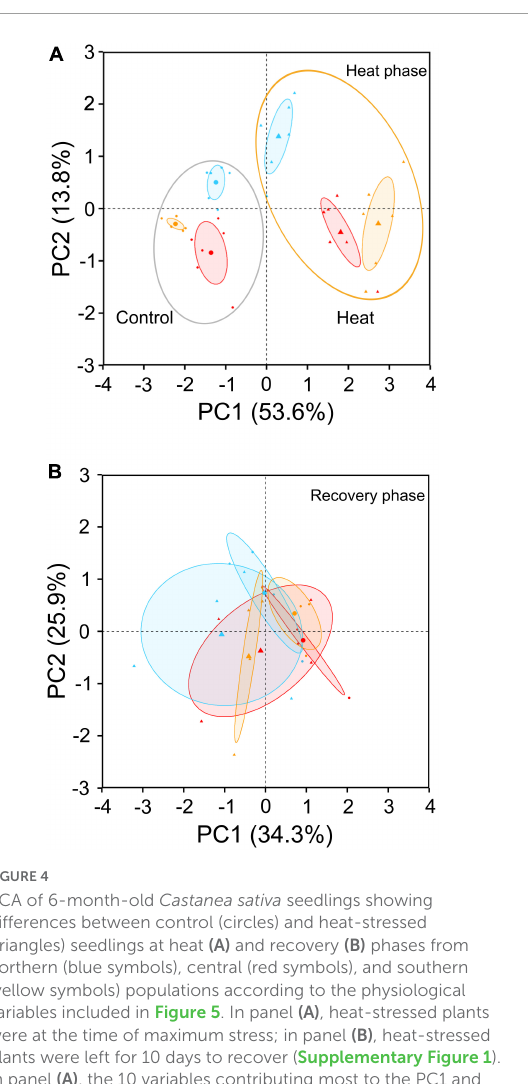
FIGURE3 DFA of 6-month-old Castanea sativa seedlings showing differences between control (circles) and heat-stressed (triangles) seedlings from the northern (blue symbols), central (red symbols), and southern (yellow symbols) populations based on the 18 compounds detected in roots and leaves by non-targeted metabolite profiling. In panel (A) , heat-stressed plants were at the time of maximum stress; in panel (B) , heat-stressed plants were left for 10 days to recover ( Supplementary Figure 1 ).